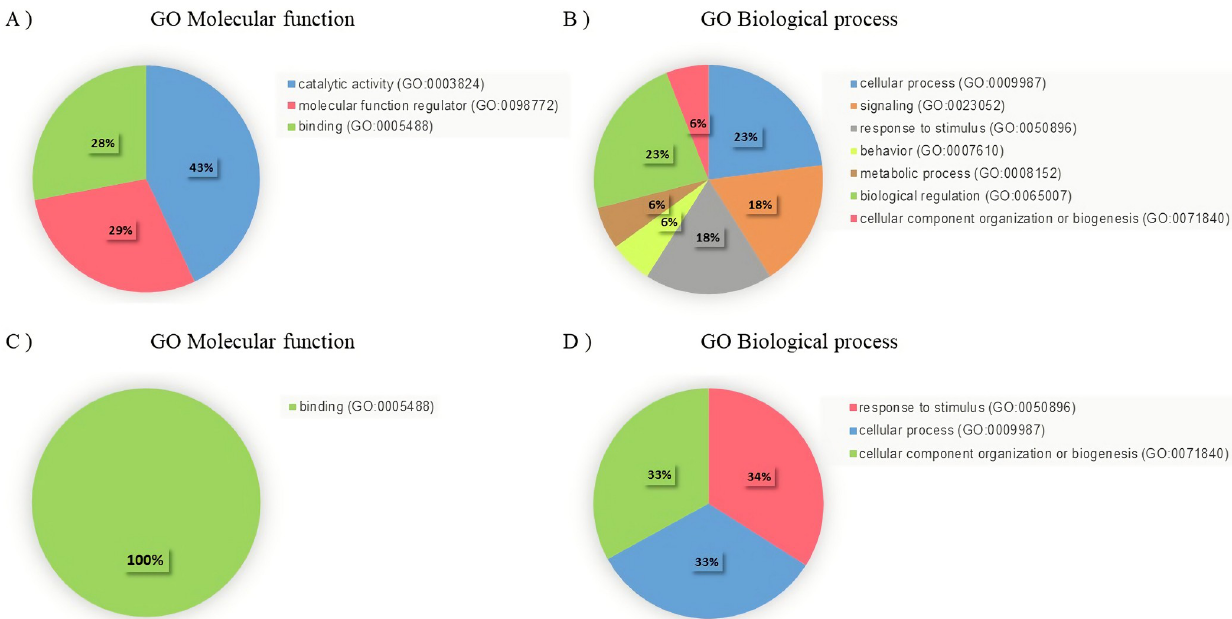
Fig 5. Classification of expressed unique proteins using the PANTHER system. Unique protein classification of the DM+COR group according to molecular function (A) and biological process (B). Unique protein classification of the N+COR group according to molecular function (C) and biological process (D).